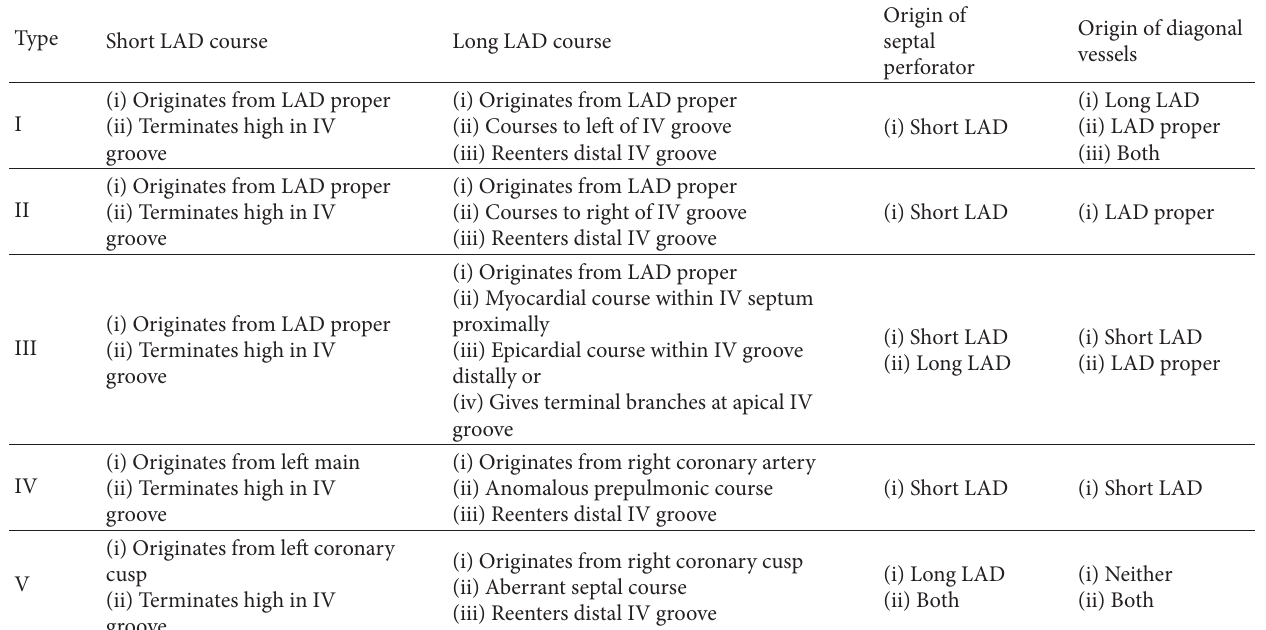
Table 1: Classification of dual LAD on coronary CTA, adapted from